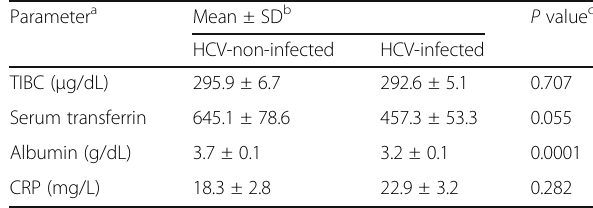
Table 2 Comparison of haematology parameters between HCV- non-infected and HCV-infected haemodialysis patients Parameter a